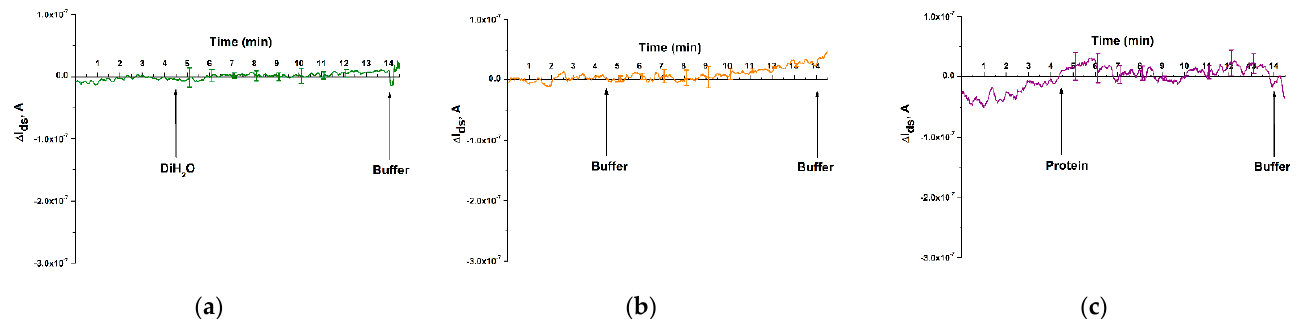
Figure 6. Results obtained upon addition of various test interfaces into the measuring cuvette of the nanoribbon biosensor: ( a ) pure deionized water; ( b ) pure 1 mM PPB; ( c ) alpha-fetoprotein (a protein marker of hepatocellular carcinoma). The experiment was carried out in a working solution of 1 mM PPB (pH 7.4), V ds = 0.2 V, V g = 50 V; the solution volume was 450 µL. Number of technical replicates, n = 3. Arrows indicate the moments of adding the test sample and washing potassium-phosphate buffer.